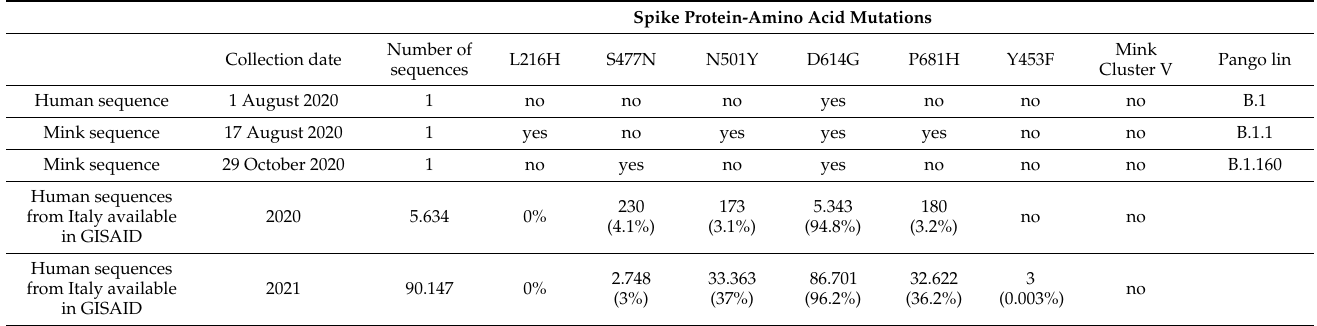
Table 3. Amino acid mutations observed in the Spike protein of the Italian human sequences available through GISAID (https://www.gisaid.org/, accessed on 30 May 2022) in 2020–2021. Spike Protein-Amino Acid